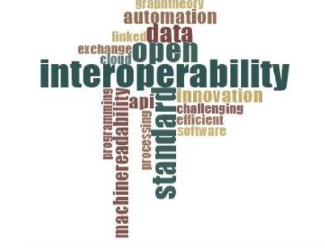
Figure 5. EUnet4DBP Principles for Process.